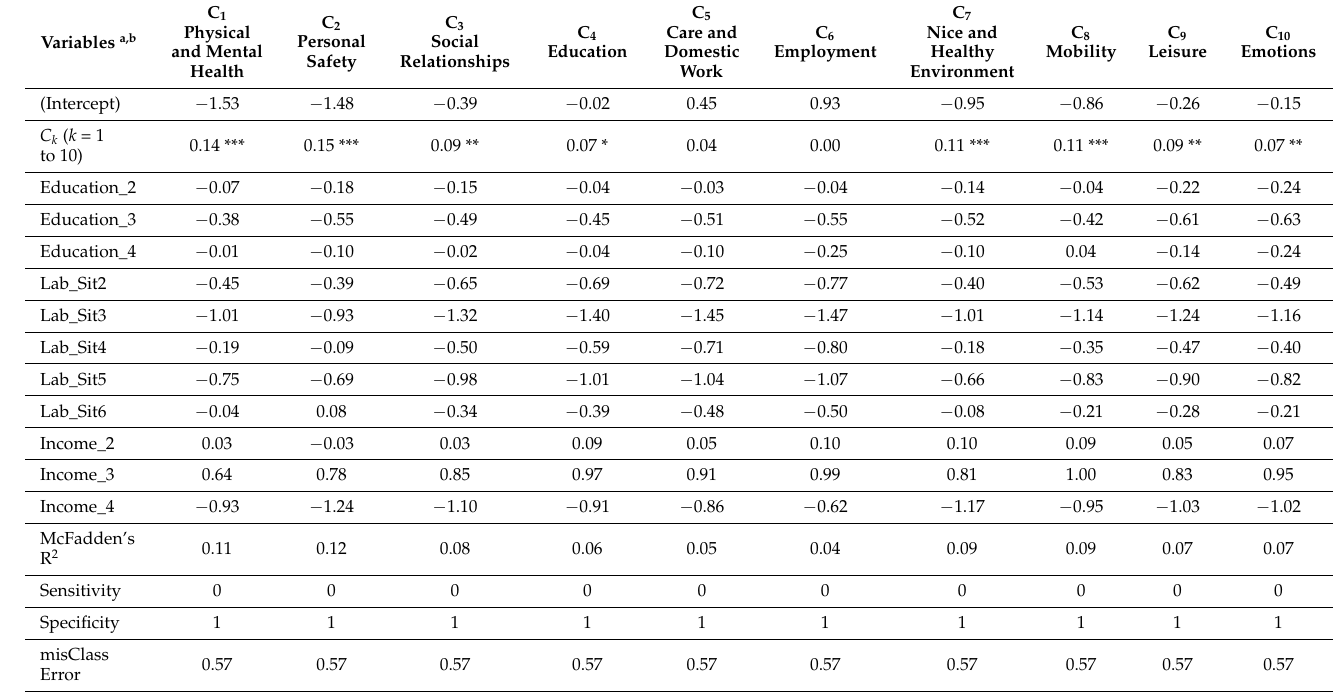
Table A4. Significance of coefficients of regressions with different capabilities. Women and age 40 to 64.